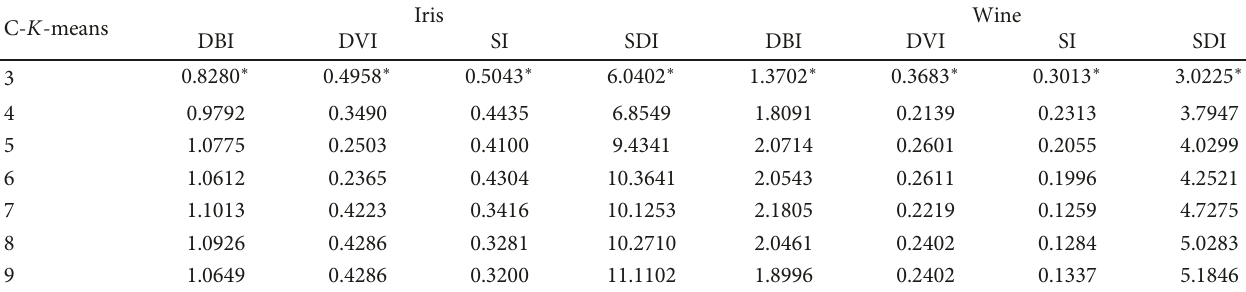
Table 3: The value of k is known (Iris and Wine; ∗ denotes the optimal value).